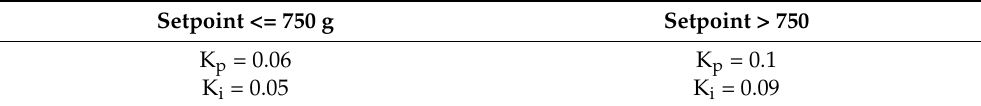
Figure 10. Control flow diagram for the proposed prosthetic system. Table 1. PI controller gains at different grasp force